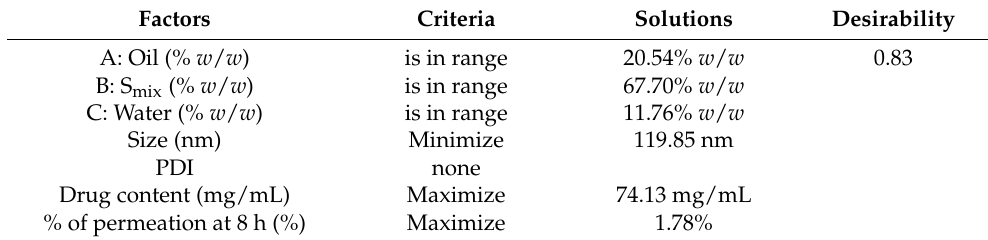
Table 2. Criteria for optimized FLUZ-loaded MEs formulation.